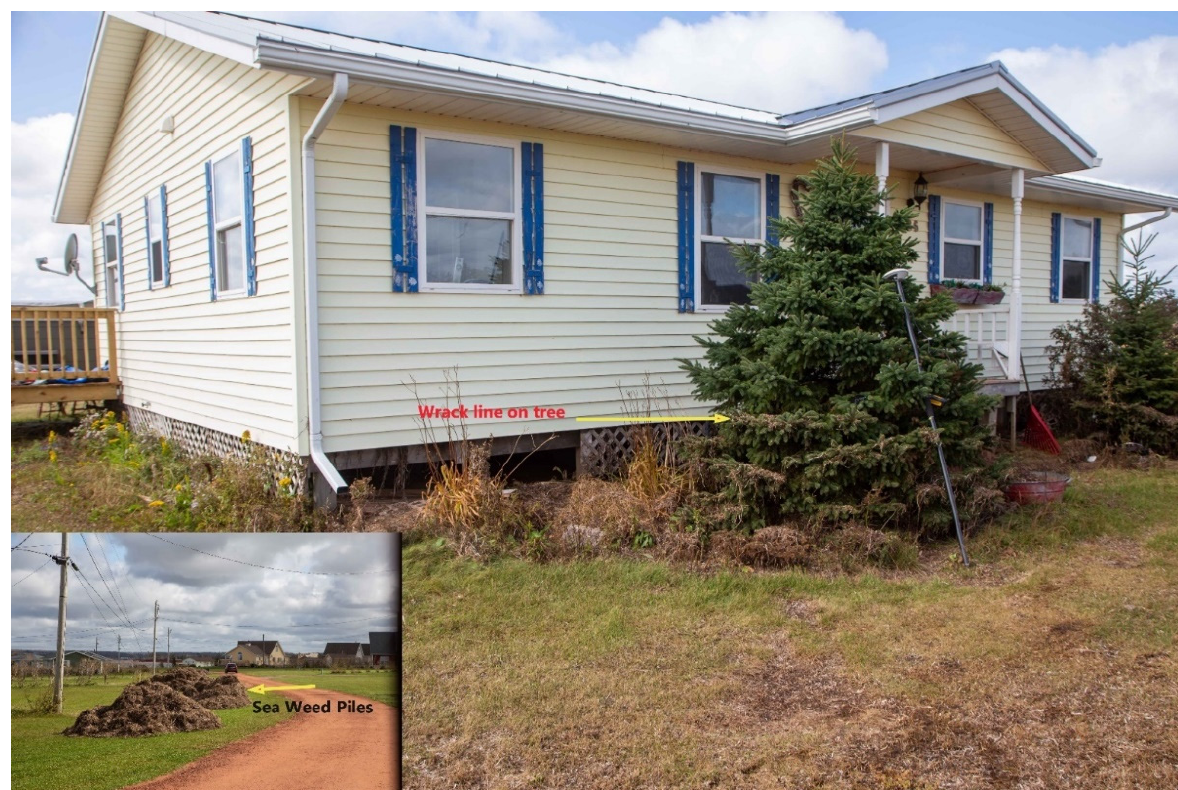
Figure 11. Seaweed wrack line on trees on MacEwen’s Island after Dorian with Inset Map Showing Sea Plant Piles.